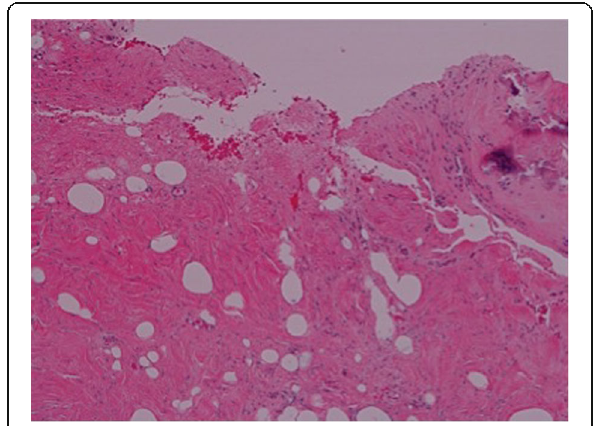
Fig. 2 High-power (40x) microscopic appearance of lateral aspect of the graft with multi-nucleated osteoblastic type